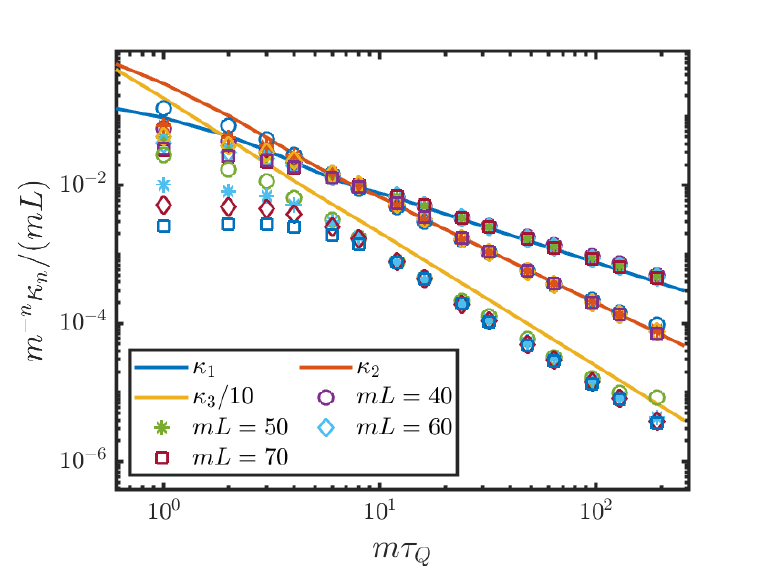
Figure 5.1: Cumulant densities for linear ramps on the free fermion line starting in the paramagnetic phase and ending at the QCP: a comparison between the numeri- cally exact solution (solid lines) in the thermodynamic limit and cutoff-extrapolated TCSA data in different volumes (symbols). For both approaches κ decade lower for better